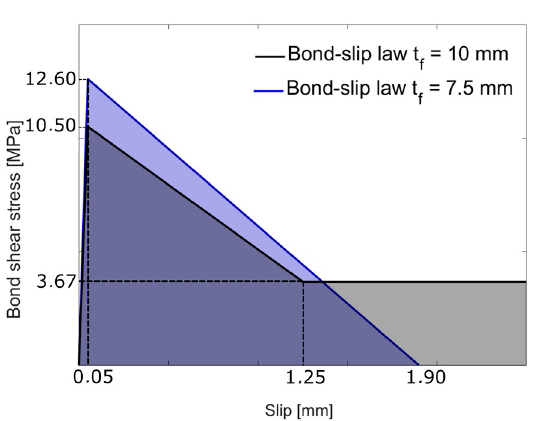
Figure 12. Experimental bond–slip laws for the NSM with 7.5 mm and 10 mm thickness grooves.